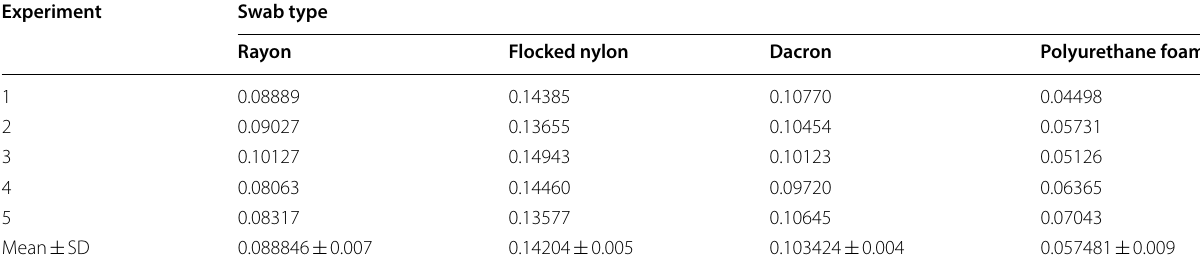
SD standard deviation